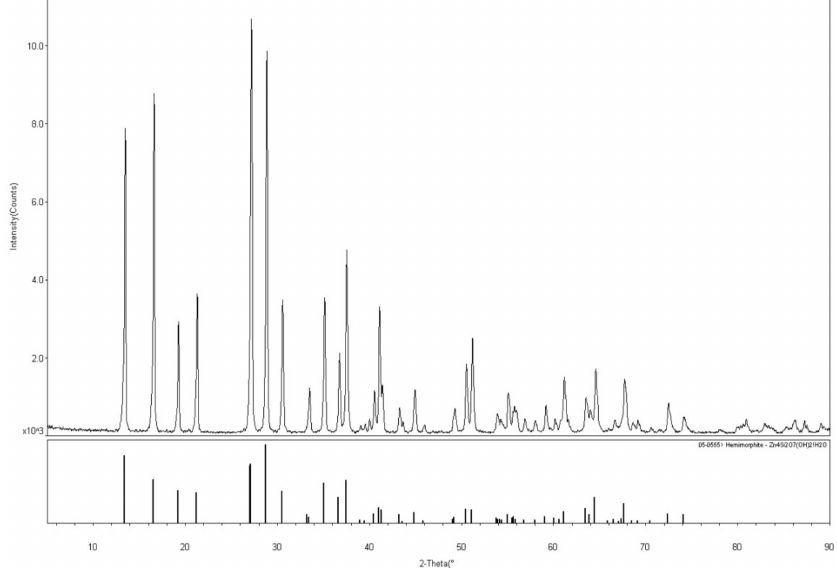
Figure 1. X-ray diffraction (XRD) pattern of the pure hemimorphite